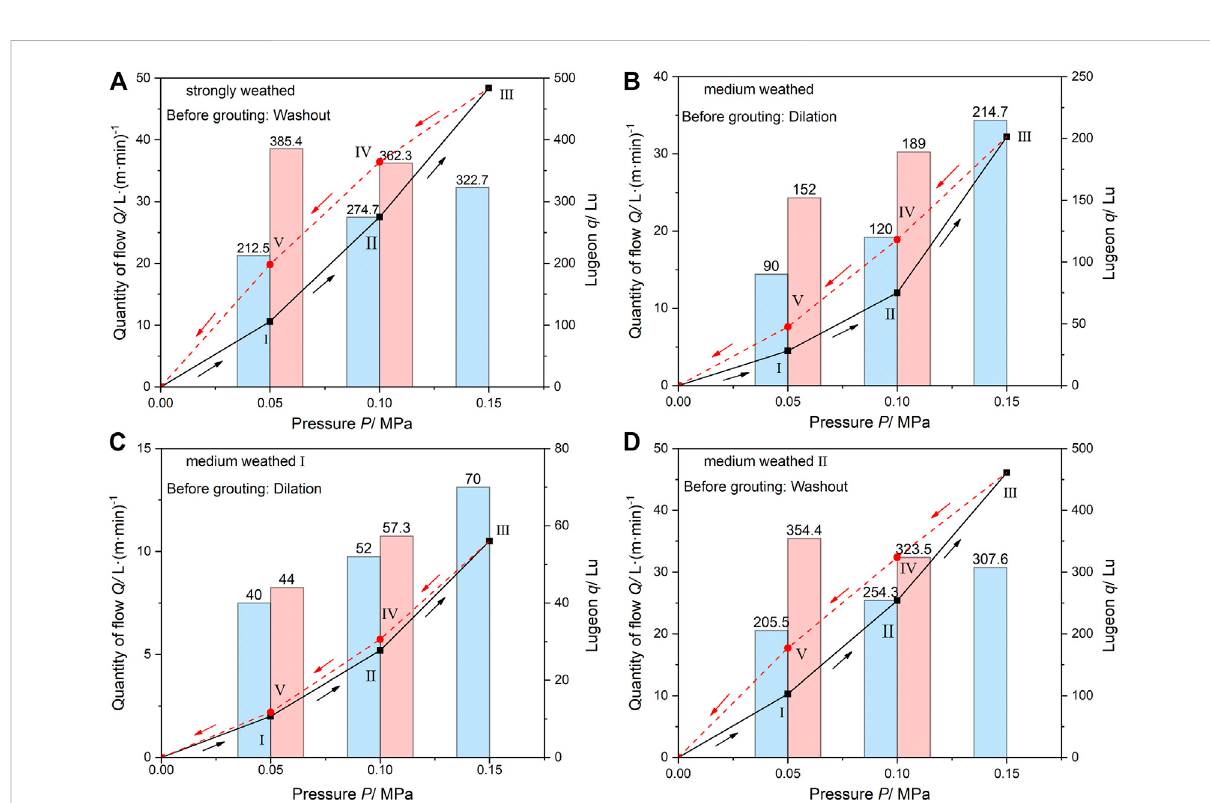
FIGURE 8 Formationpermeabilitybeforegrouting (A) stronglyweatheredformationofNo.1testarea, (B) mediumweatheredformationofNo.1testarea, (C,D) the upper and lower weathered formations of No. 2 test